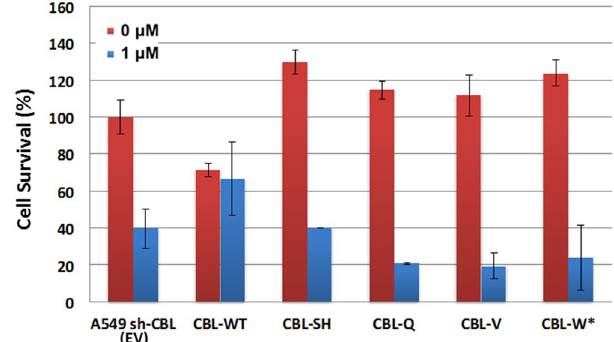
Figure 2. Cell survival of CBL Mts after treatment with MET inhibitors. A549 CBL isogenic cells with empty vector (EV) or CBL wild-type (WT) and mutations (SH: S80N/H94Y, Q: Q249E, V: V391I, W * : W802 * ). MET CBL WT.